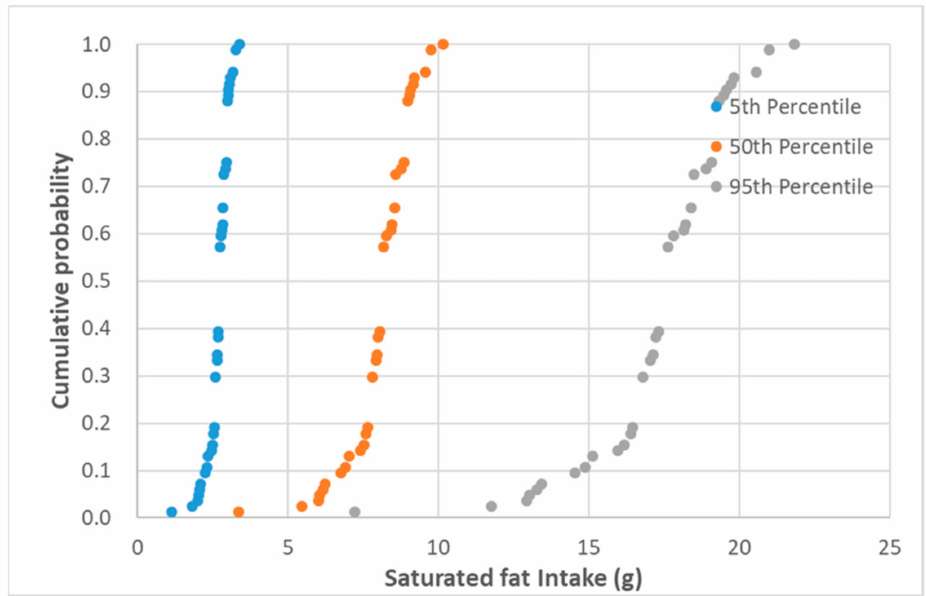
Figure 3. Cumulative probability of saturated fat (g) intake per capita and per day of Greek adults consuming graviera cheese marketed in the Greek market for the 5th, 50th and 95th percentiles of daily consumption.